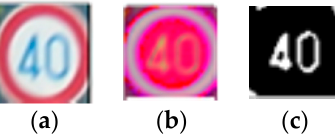
Figure 4. Extracted speed limit. ( a ) RGB image of Speed-limit sign extracted from the landscape image; (b) HSV image converted from RGB image (a); ( c ) Binarized image of image ( b) by setting the threshold for the blue.